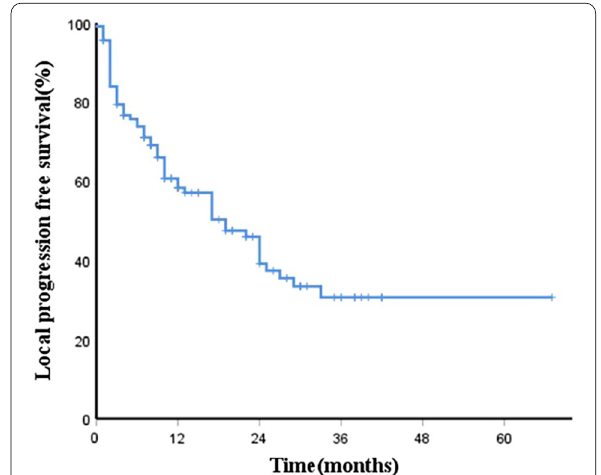
Fig. 3 Kaplan–Meier curves of local tumor progression-free survival (LTPFS). The median LTPFS was 19.0 months. The 1-, 2-, and 3-year LTPFS rates were 58.7%, 50.0%, and 41.2%,